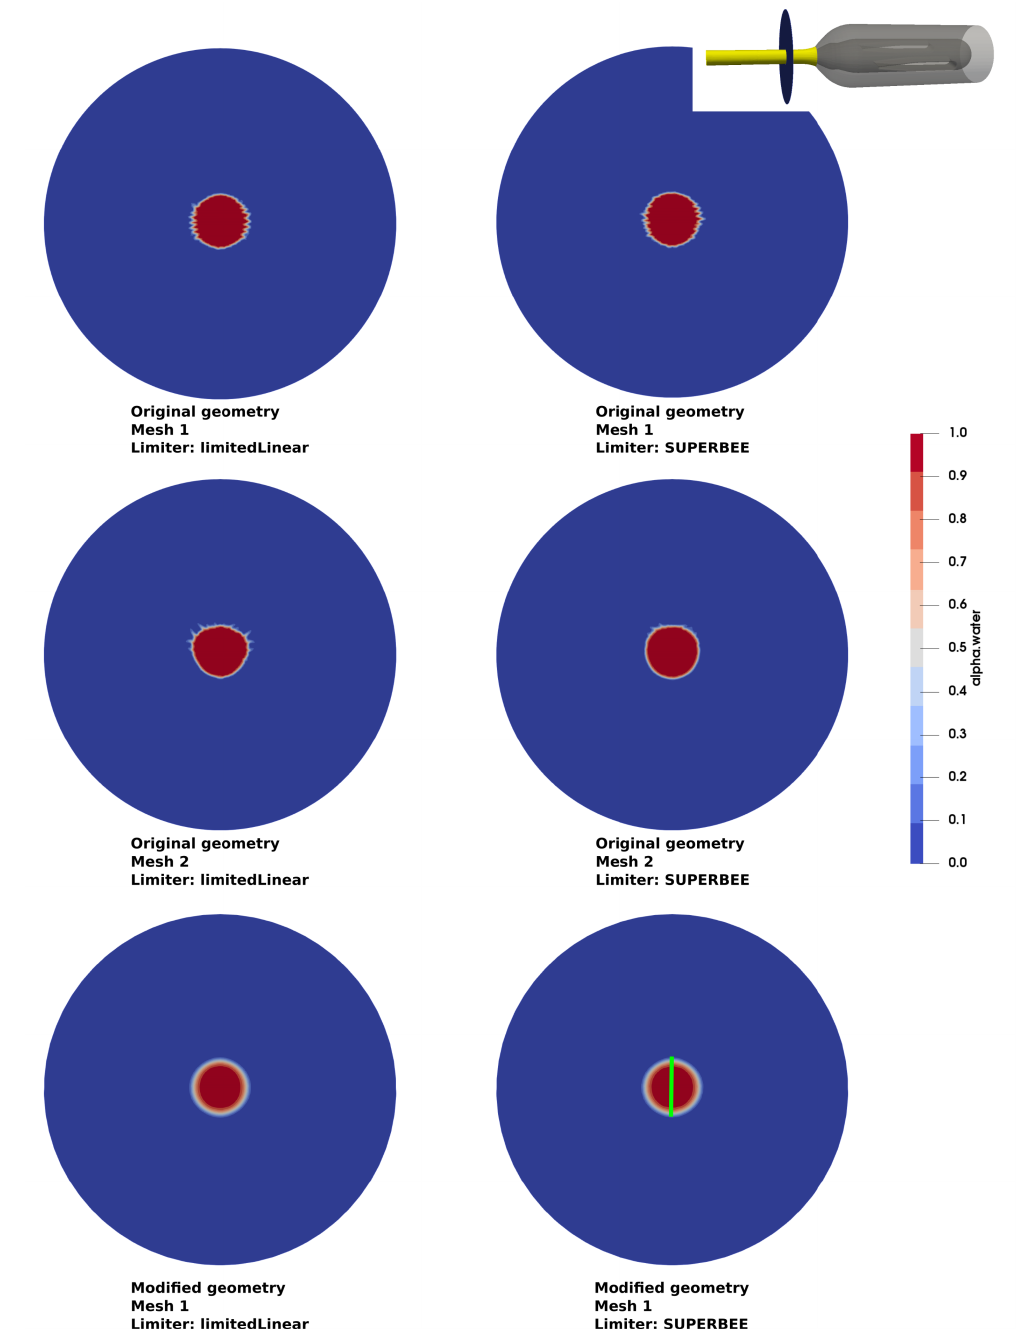
Figure 9. Contour of the liquid volume fraction ( alpha . water ) in a plane perpendicular to jet located at a distance s = 1.42 × d nozzle downstream the nozzle outlet. Simulations for a needle stroke of 50%. The green line refers to the profiles shown in Figure